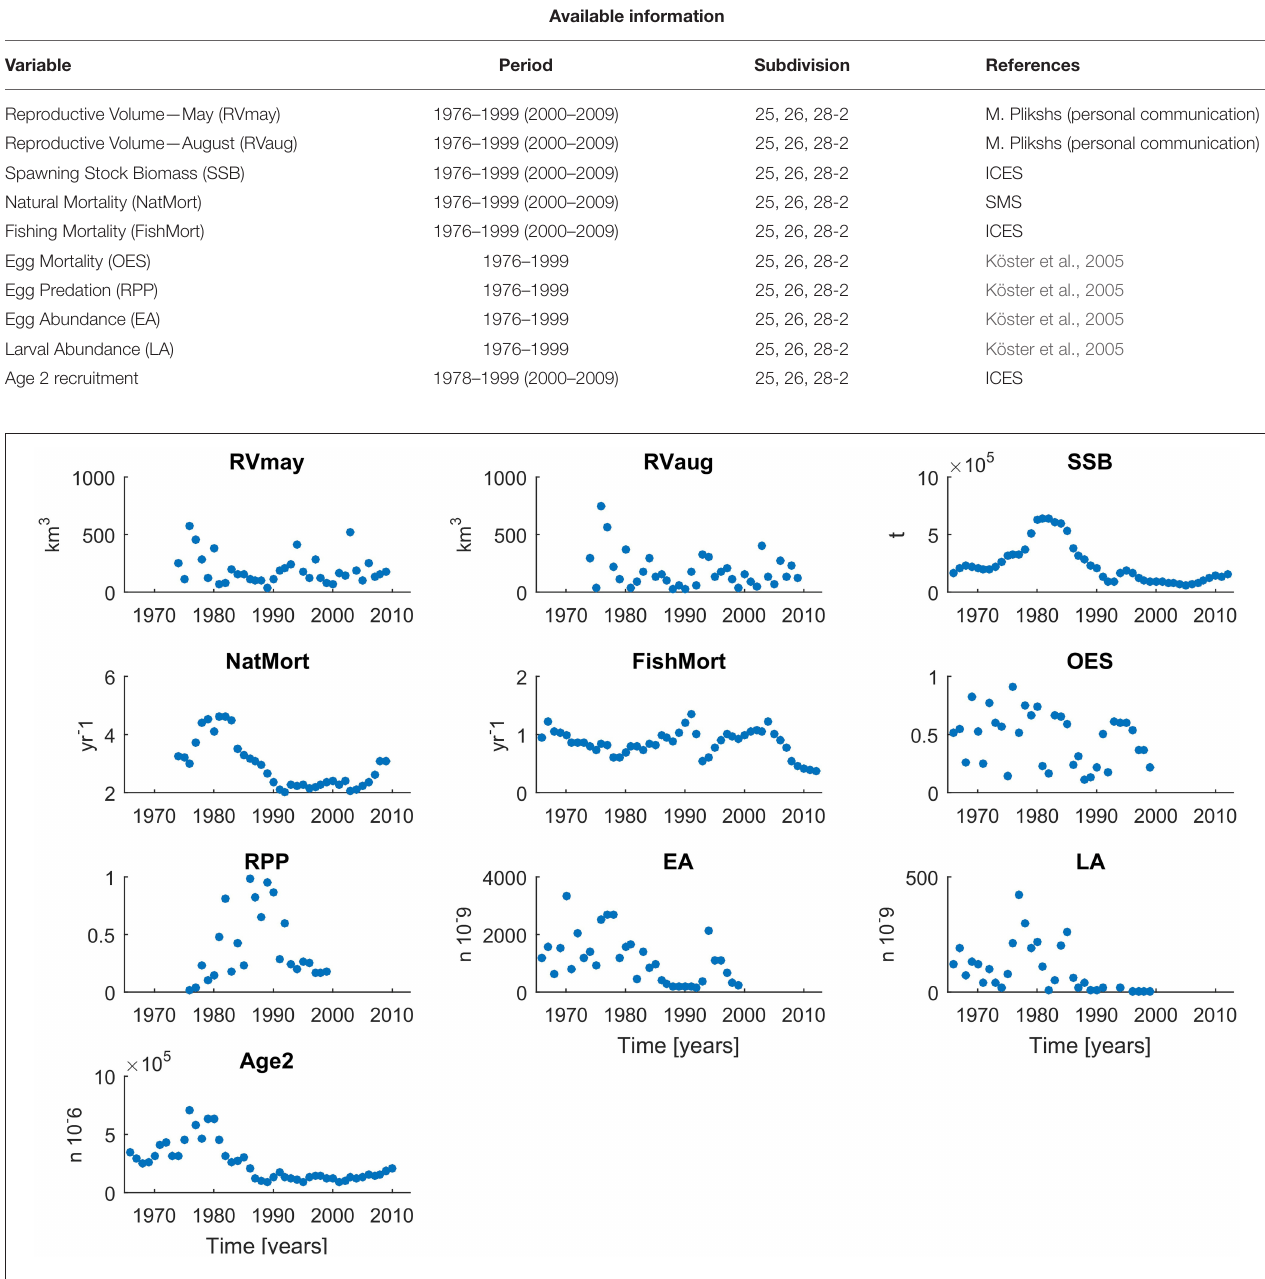
FIGURE 2 | Time series of all input and target variables used to build the FishANN model in different